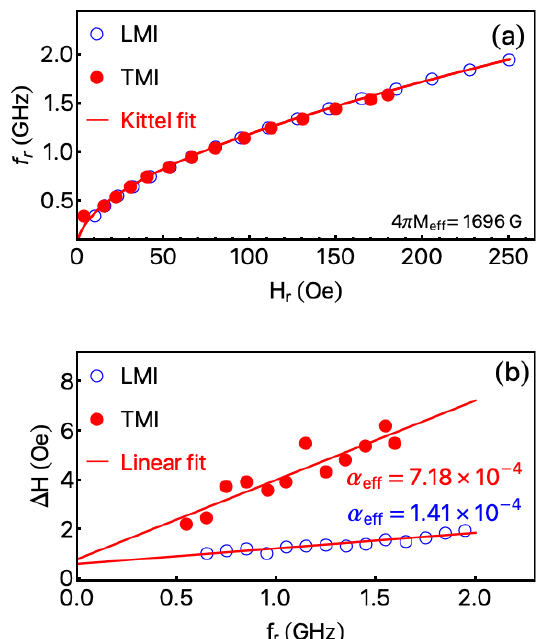
Figure 5. ( a ) Resonance frequency f r as a function of resonance field H r of the YIG/Pt-stripline system for the LMI and TMI configurations. The symbols are the experimental data and the red lines correspond to the fit obtained with the Kittel equation, Equation (5), then inferring the effective magnetization M ef f . ( b ) FMR linewidth ∆ H as a function of the f r in the LMI and TMI configurations. The symbols are the experimental data and the red lines correspond to the possible fit obtained with Equation (6), then providing an estimate of the effective damping parameters α ef f